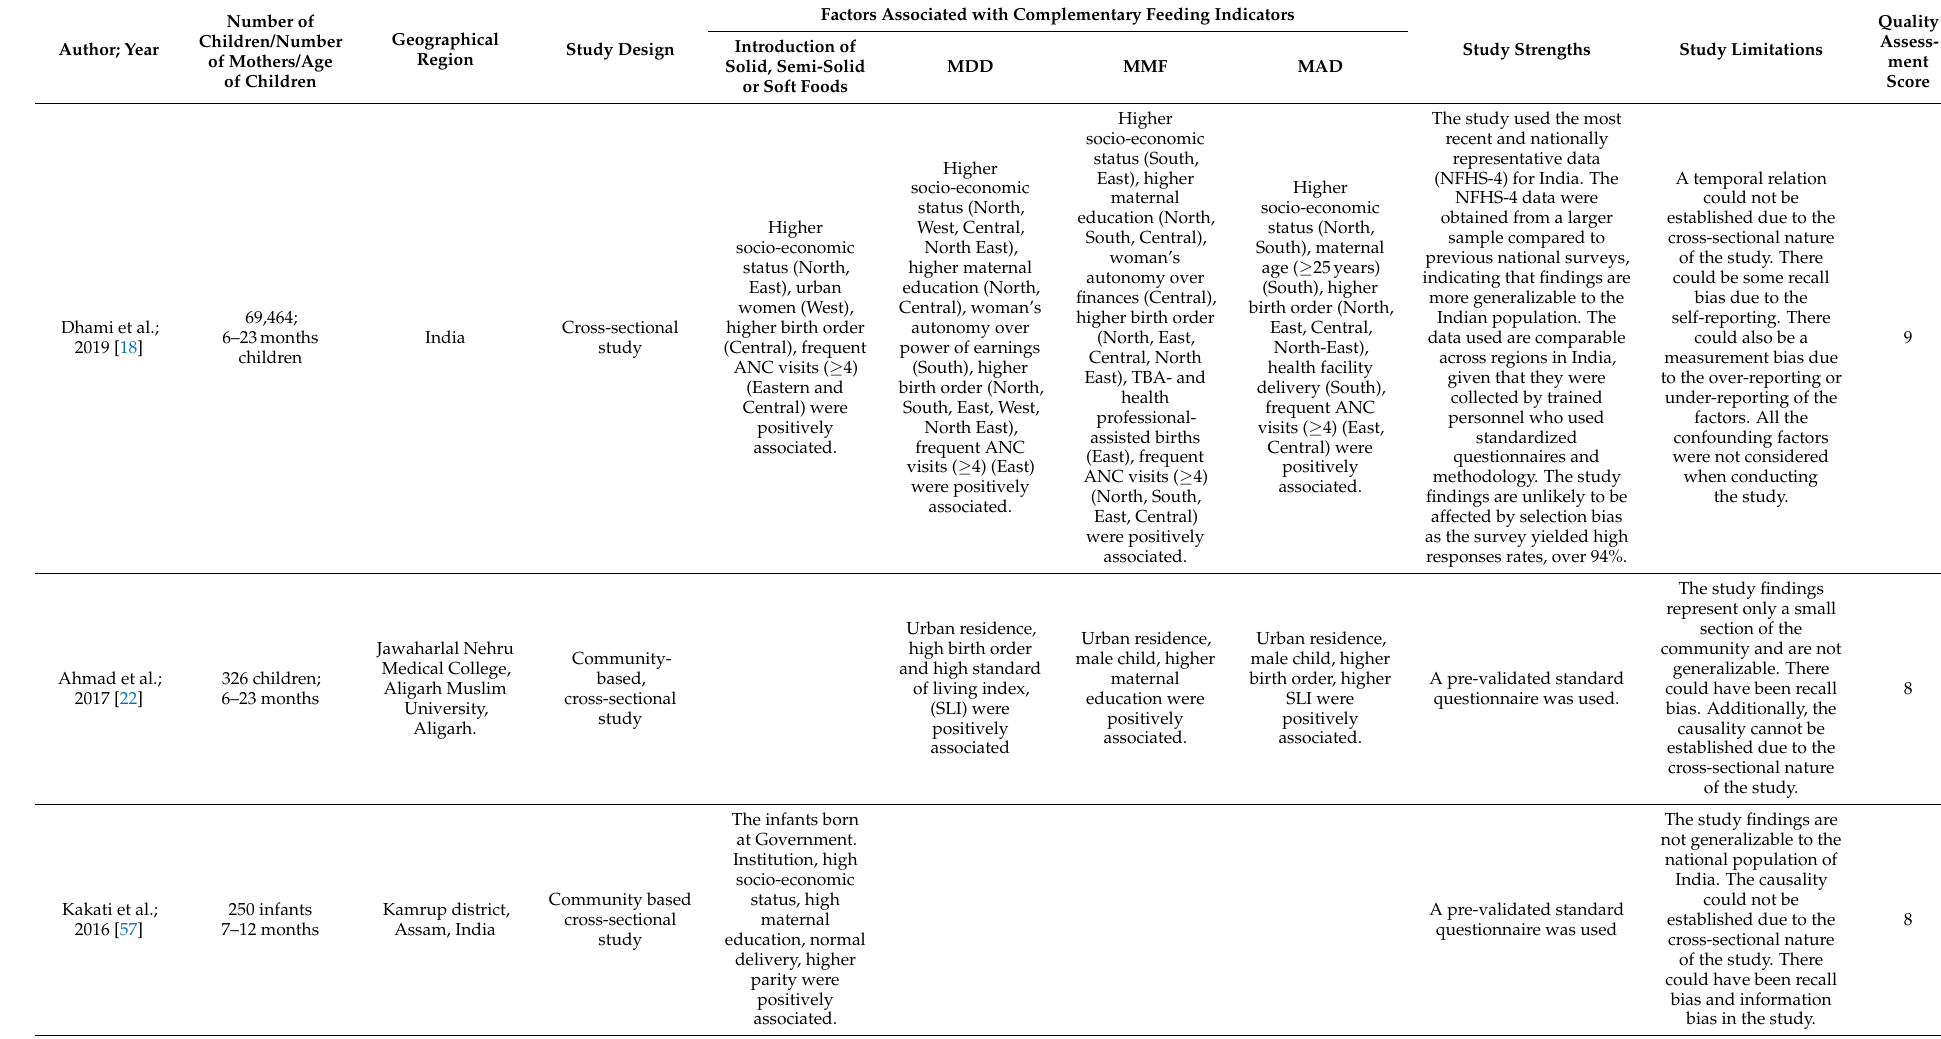
Table A2. Summary of selected studies: Complementary feeding